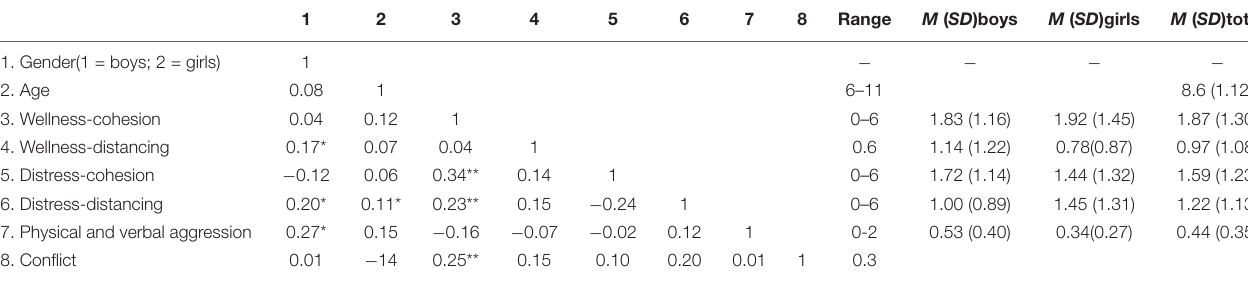
TABLE 1 | Descriptive statistics and bivariate Pearson’s correlations on study